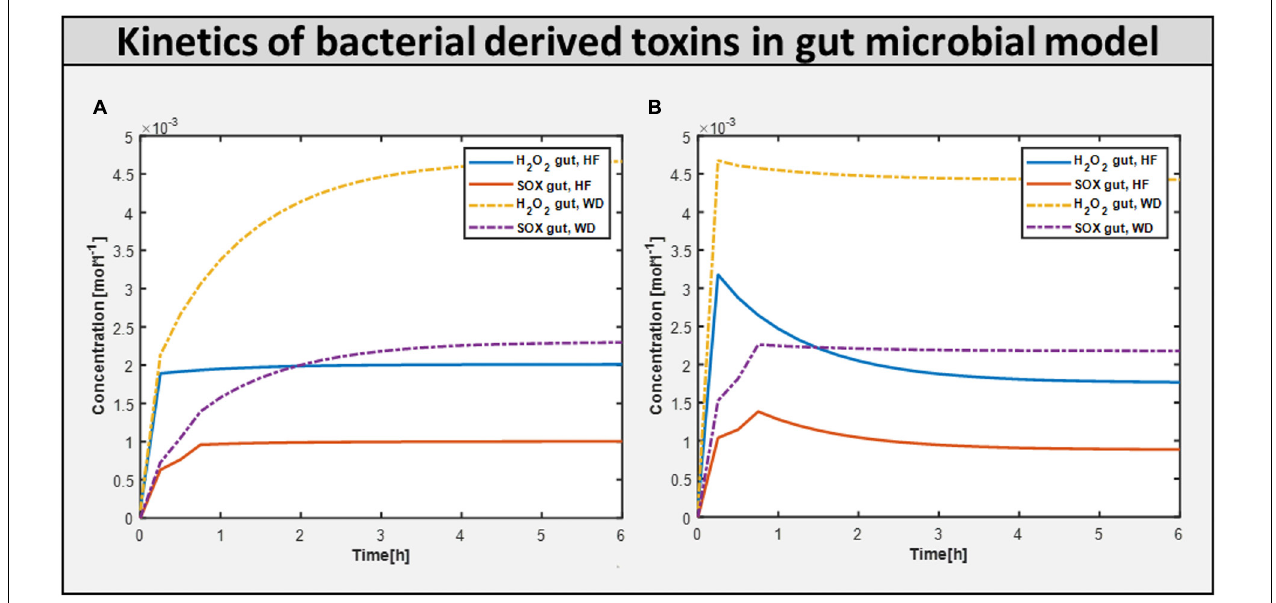
FIGURE 7 | Bacteria derived toxins. (A) Toxins produced H 2 O 2 (hydrogen perxoide) and SOX(superoxide) in Gut microbiome harmful model constrained with differential diet. (B) Toxins produced H 2 O 2 and SOX in Gut microbiome beneficial model constrained with differential diet High fiber and Western.